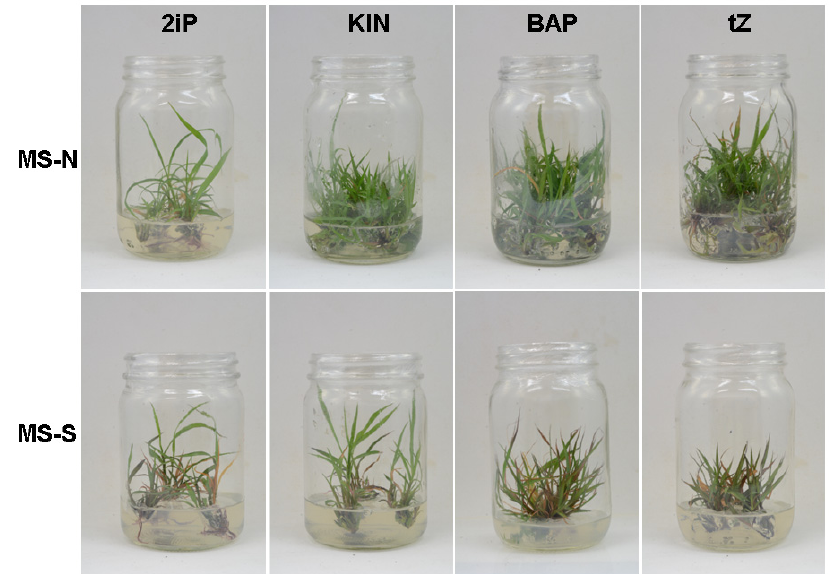
Figure 1. The effects of different types of CKs on plant morphology during micropropagation of C. citratus shoots cultured on MS-N and M-S media.